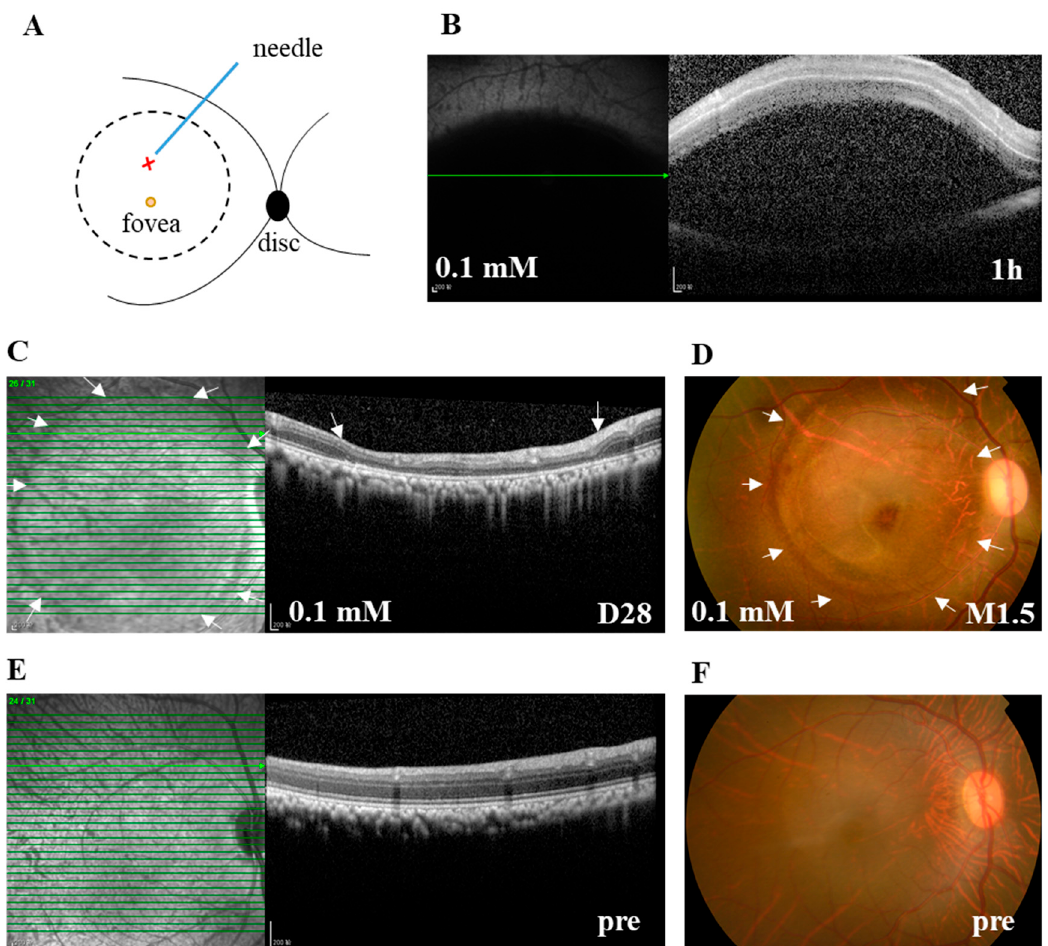
Figure 1. The subretinal injection (SI) of sodium nitroprusside (SNP) caused focal retinal lesion in monkeys. ( A ) Illustration depicts the SI site at the posterior pole of the retina. The retinotomy site by a needle is indicated with X. The bleb area caused by SI is indicated with a circle. ( B ) A typical spectral-domain optical coherence tomography (SD-OCT) image confirming the formation of subretinal bleb 1 h after SI, which indicated the successful delivery of SNP solution. ( C ) Example of SD-OCT images showing the focal retinal degeneration induced by 0.1 mM SNP SI on day 28 (D28) after the SI. ( D ) Fundus photograph also showing the local lesion surrounded by the healthy retina 1.5 months (M1.5) after the SI. ( E , F ) Examples of SD-OCT and fundus images showing the healthy retina of pretreatment (pre). Arrows in C and D indicate the lesion area. Pre: pretreatment. Scale bar: 200 μ M.